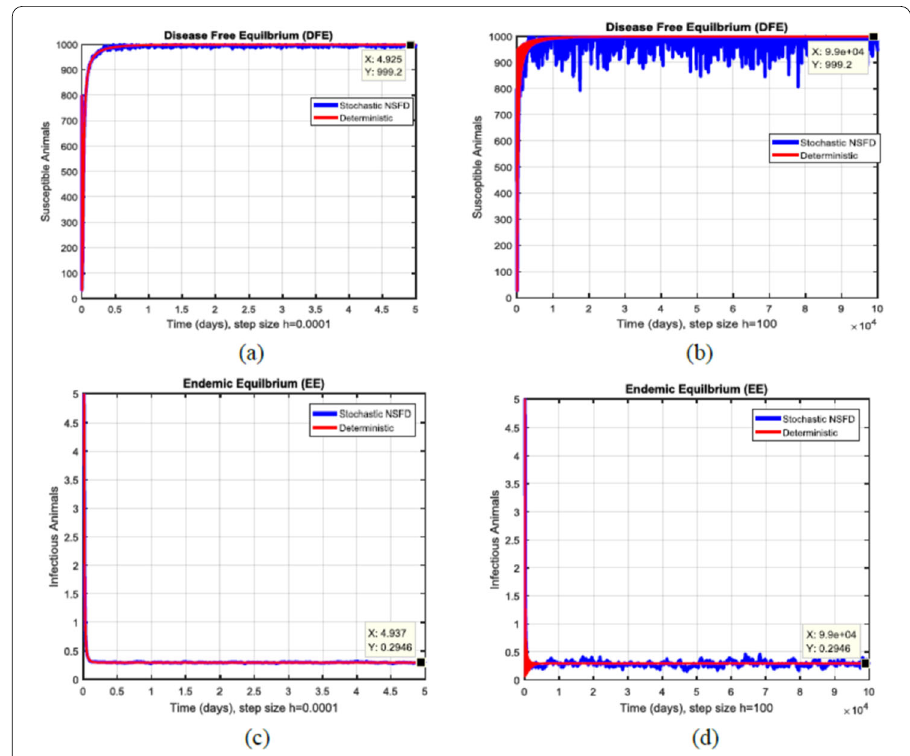
Figure 5 ( a ) Susceptible animals converge to disease free equilibria at h = 0.0001. ( b ) Susceptible animals converges to disease free equilibria at h = 100. ( c ) Infectious animals converges to endemic equilibria at h = 0.0001. ( d ) Infectious animals converges to endemic equilibria at h = 100. It means that stochastic nonstandard finite difference scheme (SNSFD) is always convergent to equilibria of model at any time step size parameter. This is the beauty of SNSFD because independent of time step size